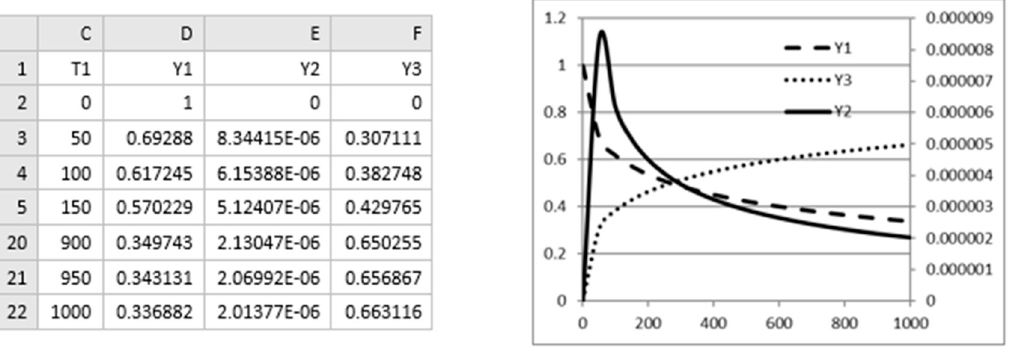
Figure A2 . Partial listing of the result computed by IVSOLVE ( left ) for system (A2), and a plot of the trajectories ( right ).